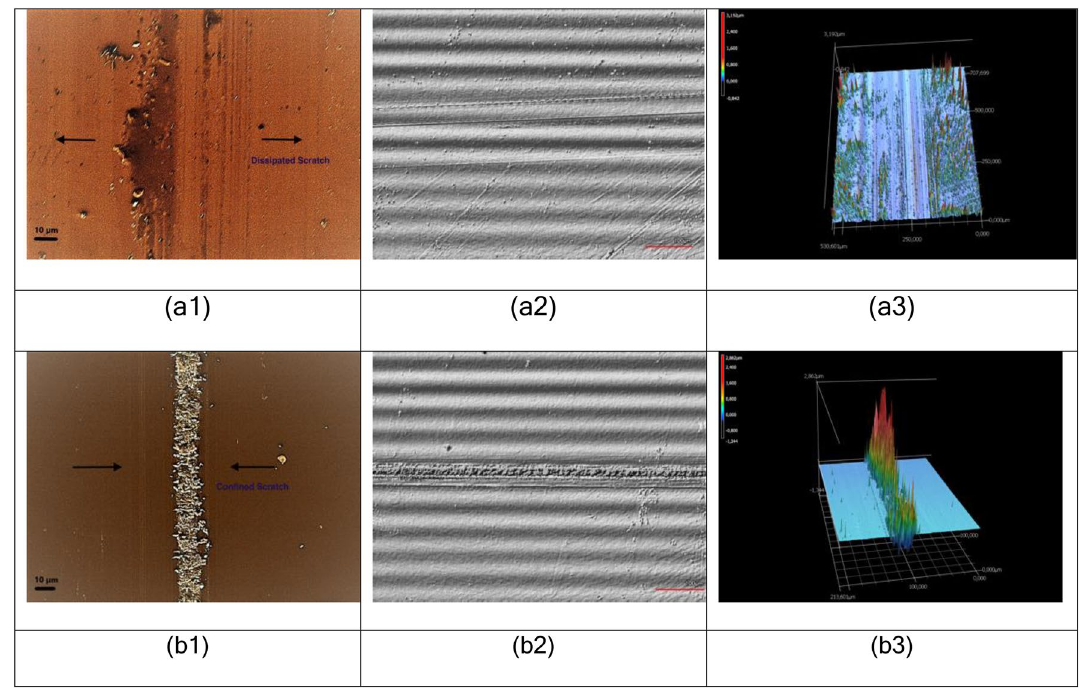
Figure 1. SEM, DIC and LSM (projected) images of scratches generated at 5 N on (a) untreated (b) heat-treated (510 °C, 30 min) SLS glass